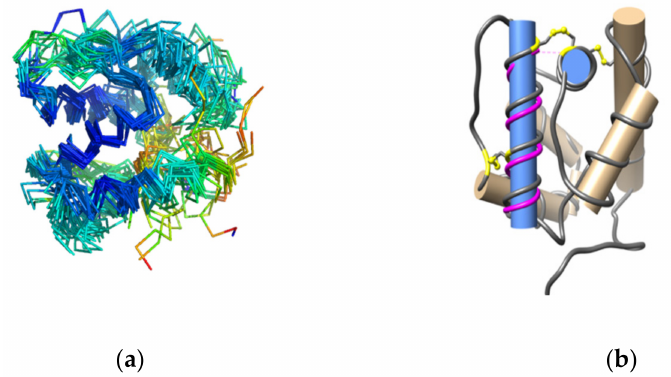
Figure 3. Visualisation of the superposed OBP structures. The helical regions coloured in blue show the least deviation in the positions of backbone Ca atoms (Panel a ). Geometry of the residues comprising the conserved structural core (residues of the conserved core are depicted in the ribbon coloured in magenta). The two helices of the “conserved” geometry are shown in blue. AgamOBP1 (3n7h) was used in the example (Panel b ).